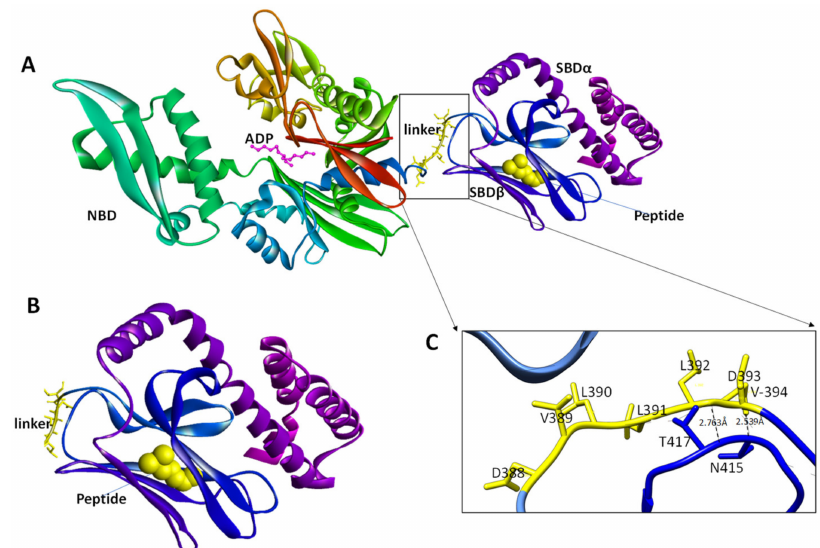
Figure 6. Three-dimensional model of Hsp70 SBD bound to peptide substrate. The middle segment of the linker assumes a coil in ADP bound state ( A ) and the peptide is enclosed into the substrate binding cleft ( B ). The linker forms hydrogen bonds with the SBD in the peptide bound state ( C ). The linker residue V394 with SBD residue N415, while L392 binds T417. The template c2khoA [57] was used for the three-dimensional modelling process.